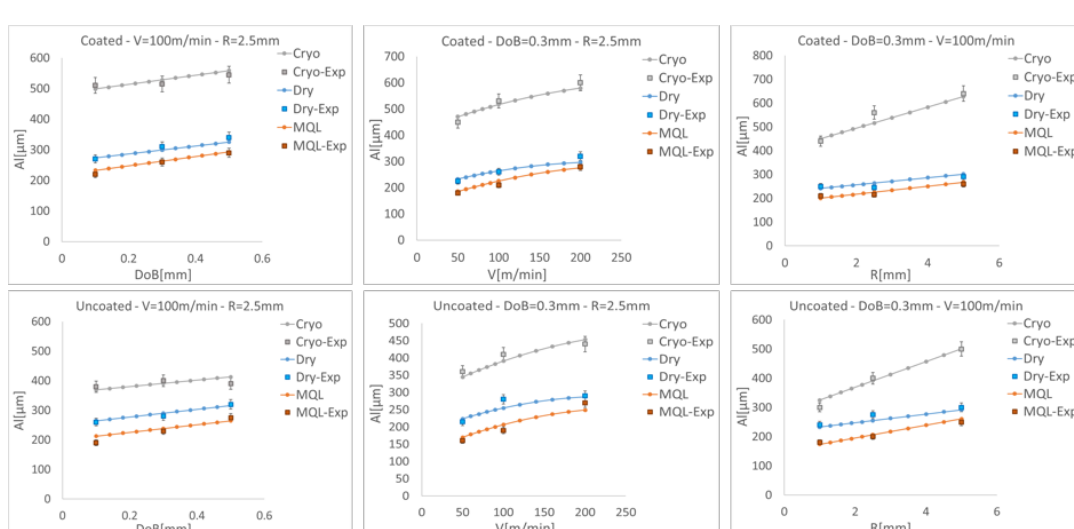
Figure 8. Model prediction of affected layer Al vs. experiments.